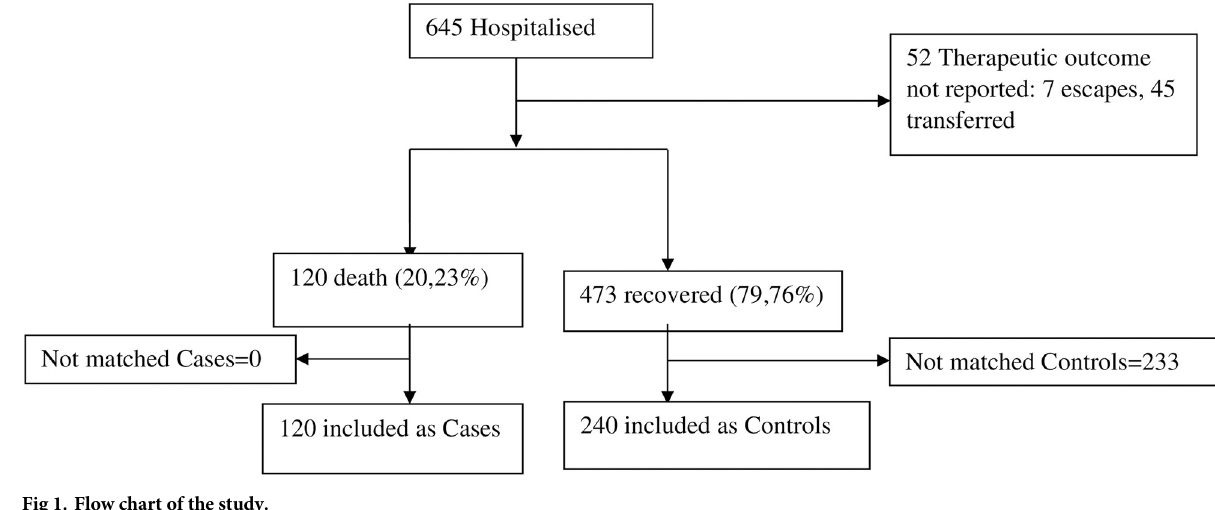
Fig 1. Flow chart of the